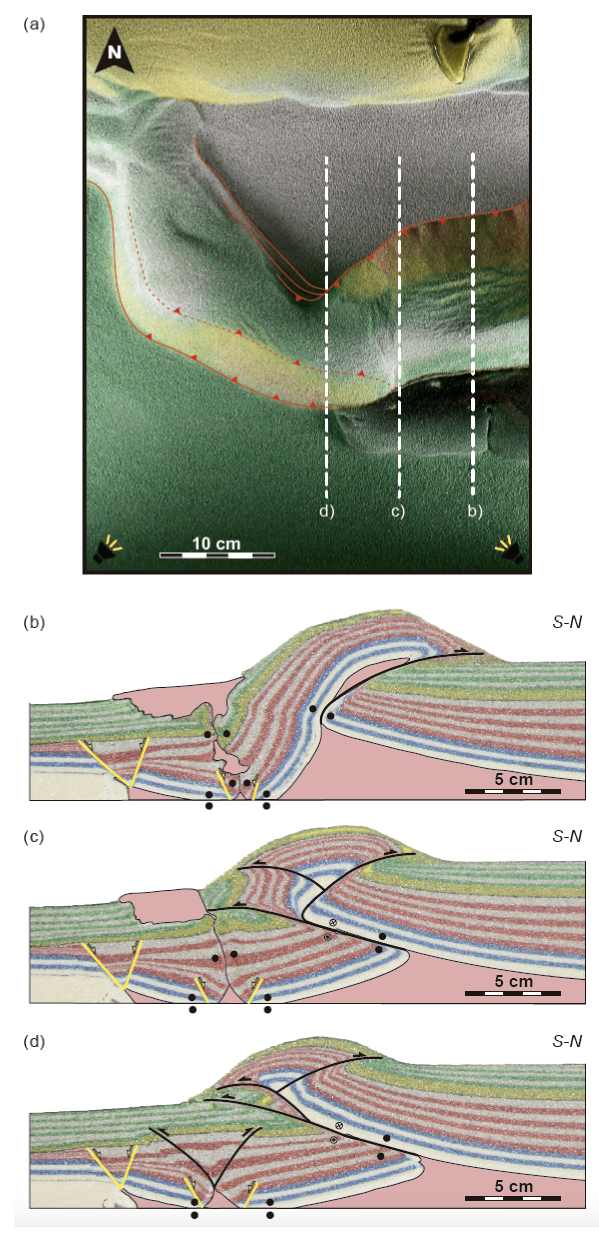
Figure 11. Detailed overhead view of model 3 at the end of com- pressional deformation. (b–d) Detailed cross-sections showing the vergence variation between the decoupled and the transitional do- mains. See section’s location in Fig.